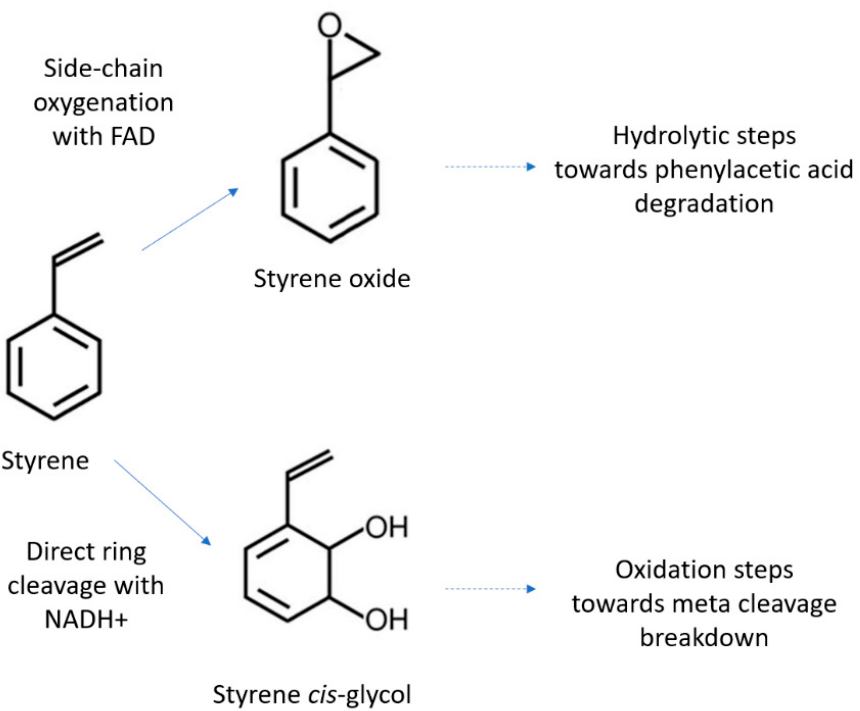
Figure 3. Two major aerobic degradation routes of styrene in microorganisms such as Pseudomonas . Essential coenzymes FAD = Flavin Adenine Dinucleotide (an essential coenzyme) and NAD = Nicotinamide adenine dinucleotide, required for metabolism.